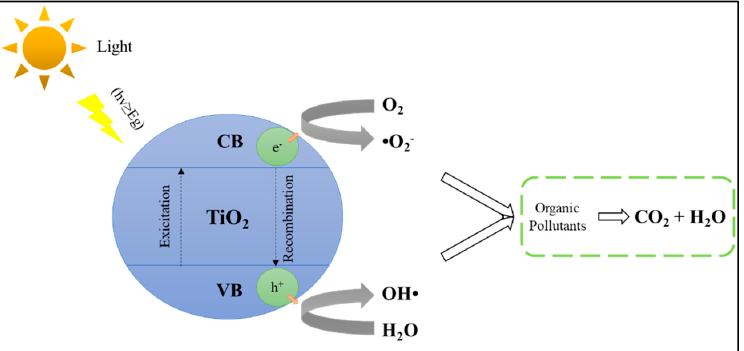
Figure 14. The schematic mechanism of photocatalysis using a semiconductor-based catalyst